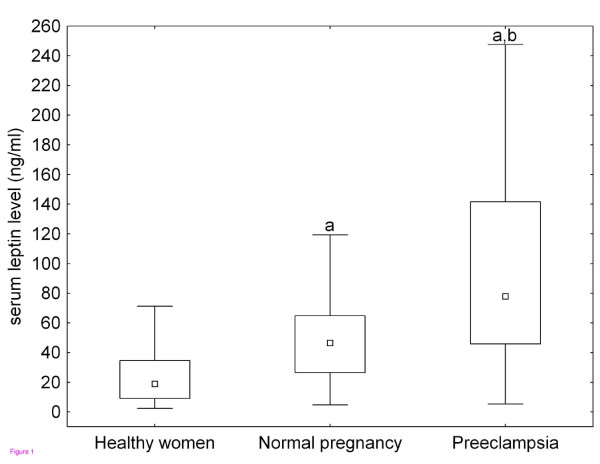
Serum leptin levels of healthy non-pregnant and pregnant women and preeclamptic patients. Middle point: median; Box: interquartile range (25-75 percentile); Whisker: range (excluding outliers). a p < 0.001 versus healthy non-pregnant women; b p < 0.001 preeclamptic patients versus healthy pregnant women.